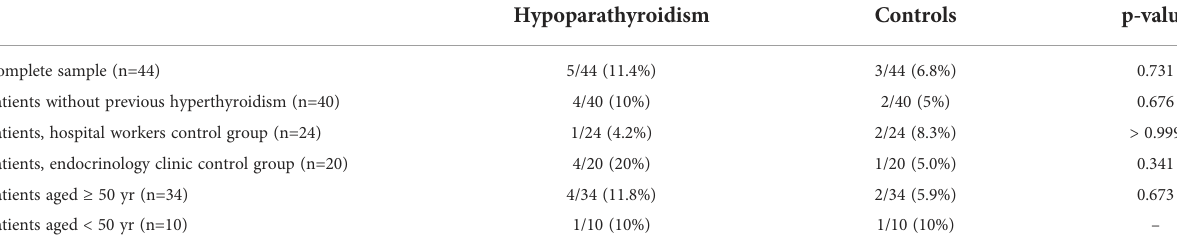
TABLE 4 Incidence of morphometric vertebral fractures in subgroups of patients with postsurgical hypoparathyroidism and controls.